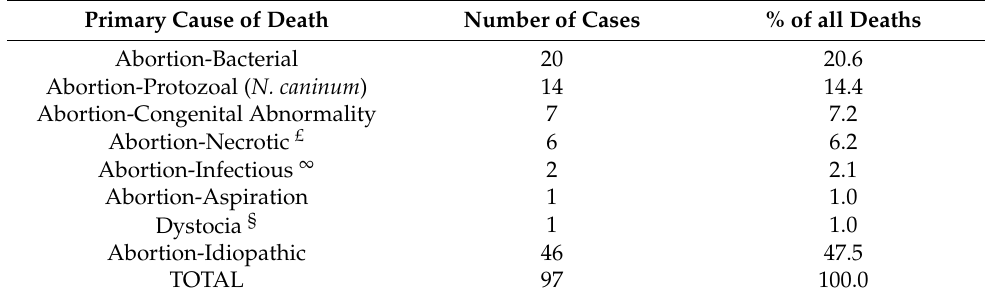
Table 2. Primary cause of death of 97 dairy cattle fetuses diagnosed at necropsy.